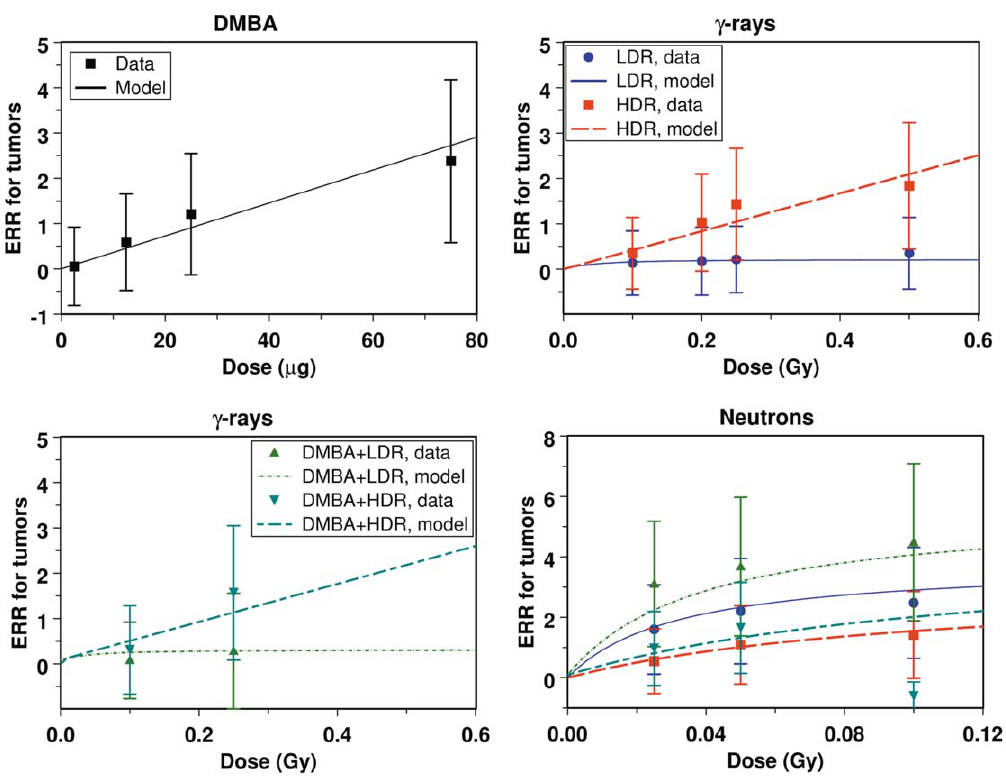
Figure 1. The data and model predictions for mammary tumor ERR after c -ray, neutron and/or DMBA exposure. In the panels showing effects of c -rays and neutrons, the legend is the same: HDR=high dose rate; LDR=low dose rate; DMBA=2.5 m g of DMBA. In this and the following figures error bars represent 95% confidence intervals.